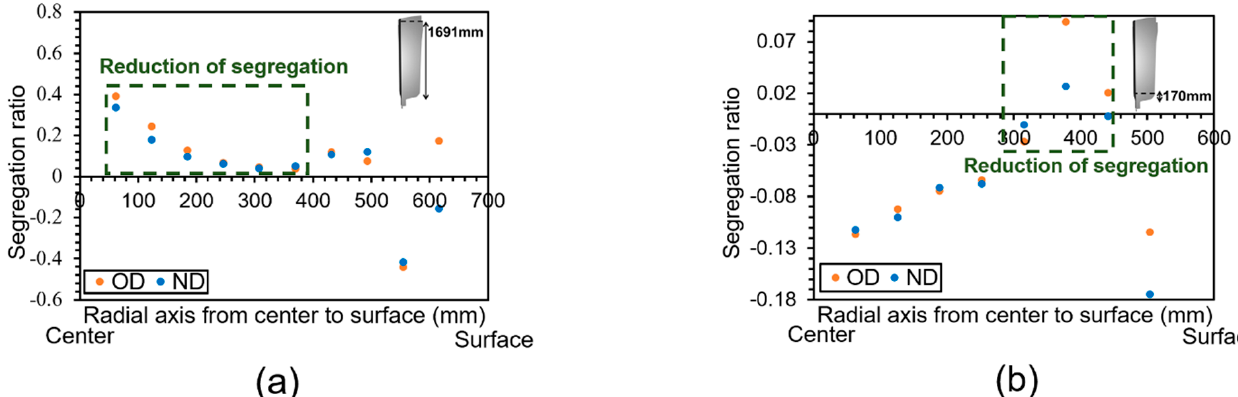
Figure 8. Carbon macrosegregation ratio when solidification is complete in OD and ND: ( a ) Along the radial axis at the hot top (height of 1691 mm from the bottom), and ( b ) Along the radial axis at the bottom (height of 170 mm from the bottom) .